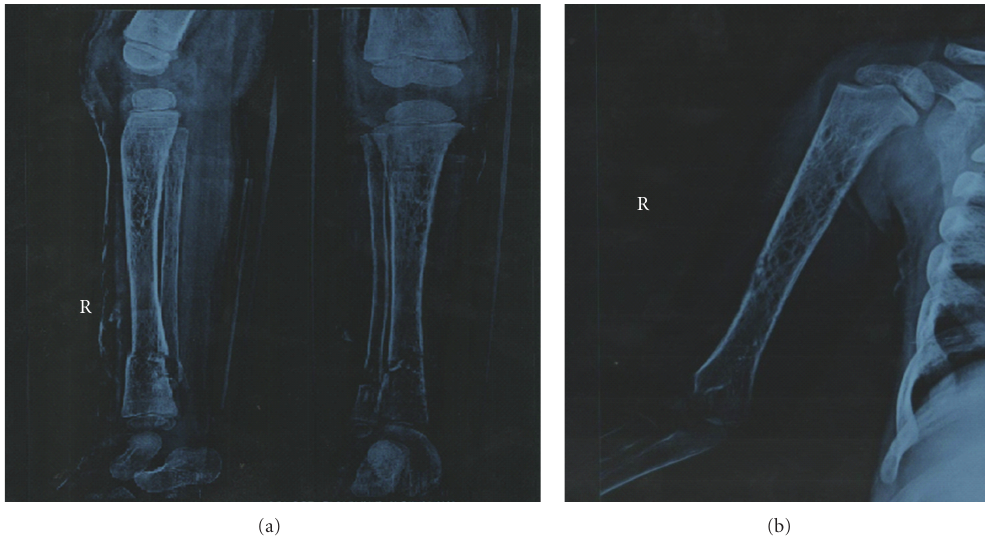
Figure 2: (a) X-ray of RT T/F AP/LAT shows osteoporosis and fractures. (b) X-ray of RT humerus shows severe osteoporosis.